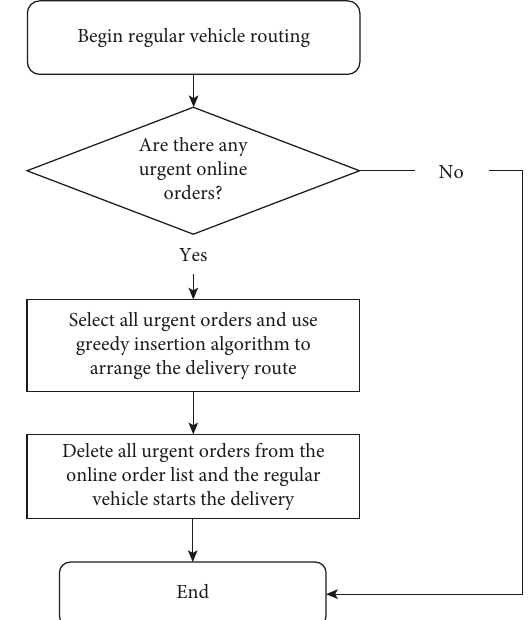
Figure 6: Regular vehicle